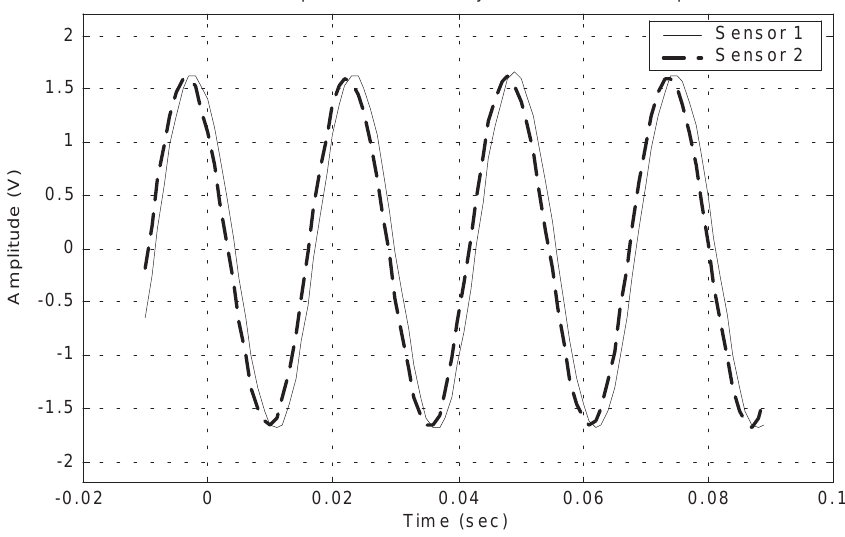
Fig. 11. Time responses of sensors S1 and S2 on the healthy beam for the sinusoidal input. to each beam. The PZT patch near the clamped end of the beam is used as the actuator (A). The second and third PZT patches are used as sensors (S1 and S2). The measurements were recorded by a LeCroy oscilloscope at a 10 kHz sampling rate and downloaded onto a PC hard drive through a RS-232